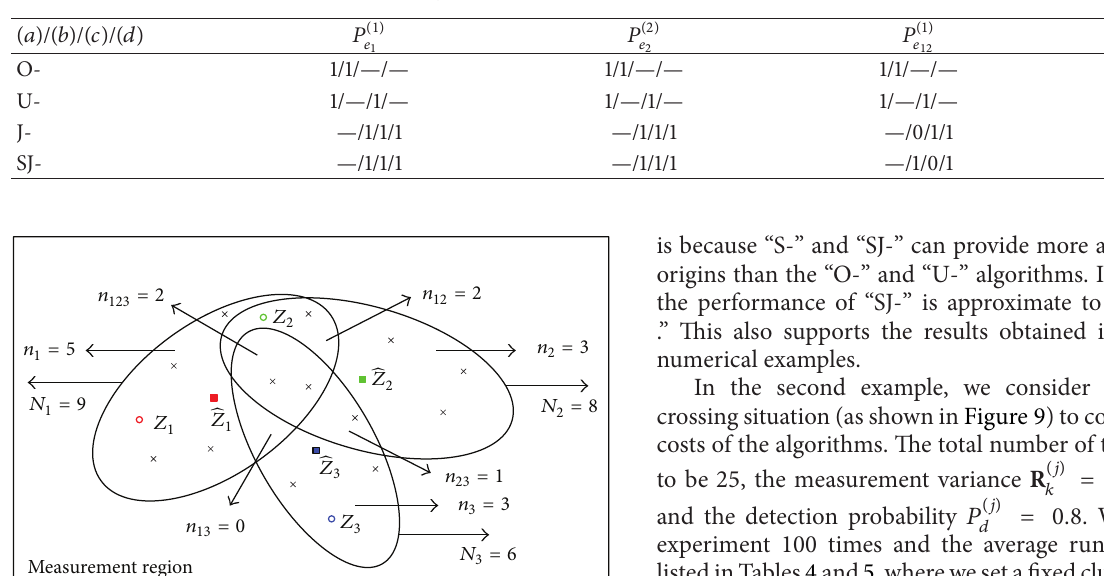
Table 1: The 𝑃 (𝑗) 𝑒 obtained by four different methods: two-target situation. 𝑟